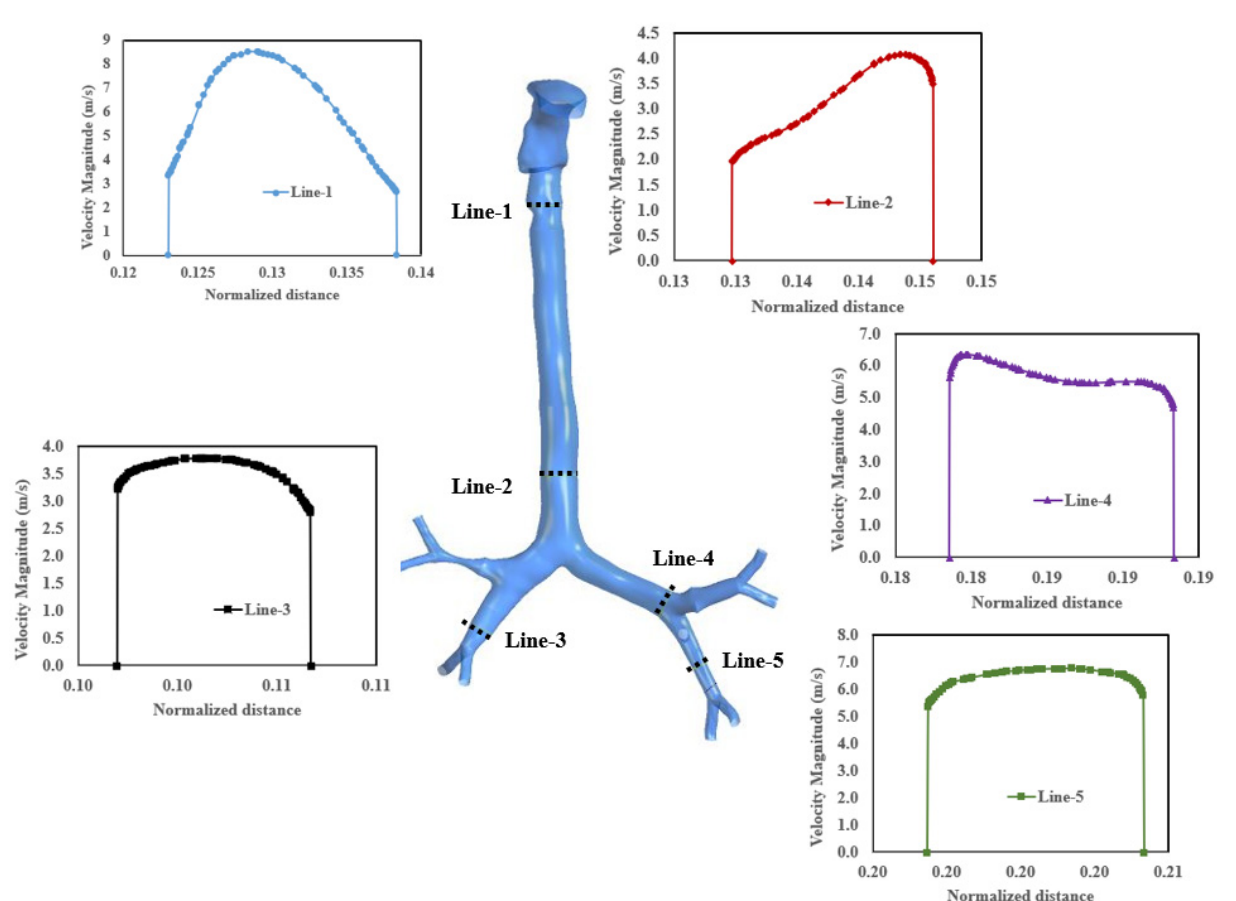
Figure 15. Velocity profiles at different cross-sections in the mouth–throat and tracheobronchial airways at a flow rate of 60 l/min.